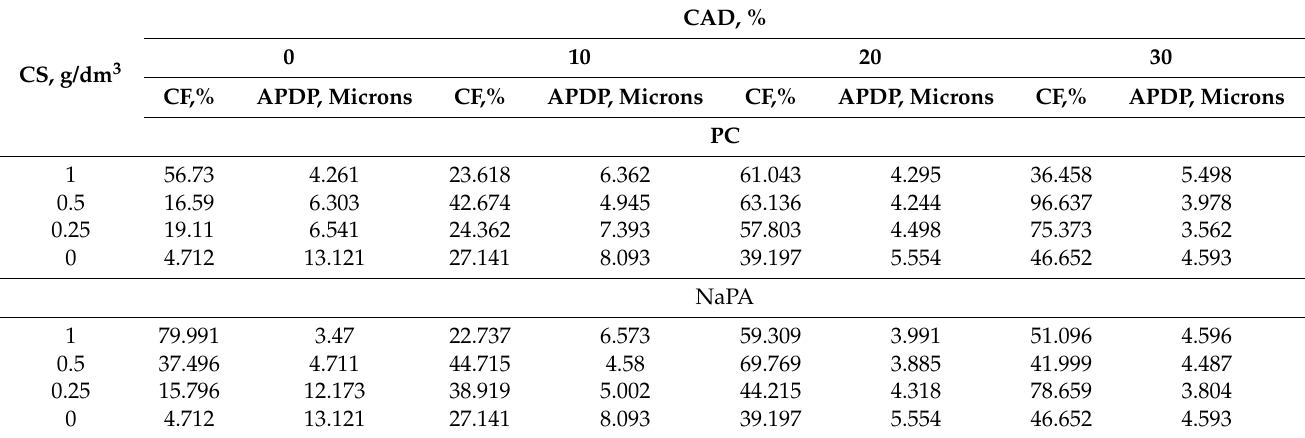
Table 5. Multilevel design matrix of two-factor experiment.